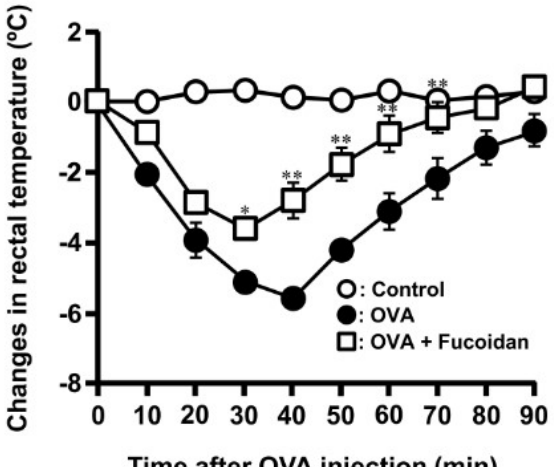
Figure 1. Oral administration of F-fucoidan suppresses the decrease of rectal temperature induced by ovalbumin (OVA) injection. Mice were orally administered F-fucoidan (60 μg/mouse/day) and immunized by injection of OVA and administrated as described in the Materials and Methods. Rectal temperature was measured every 10 min for 90 min immediately following intravenous injection of OVA (5 μg/mouse). * p < 0.05, ** p < 0.01 significantly different from the values of the group that was not administrated F-fucoidan and injected OVA (OVA control). Values represent means ± SE of 4–5 mice in each